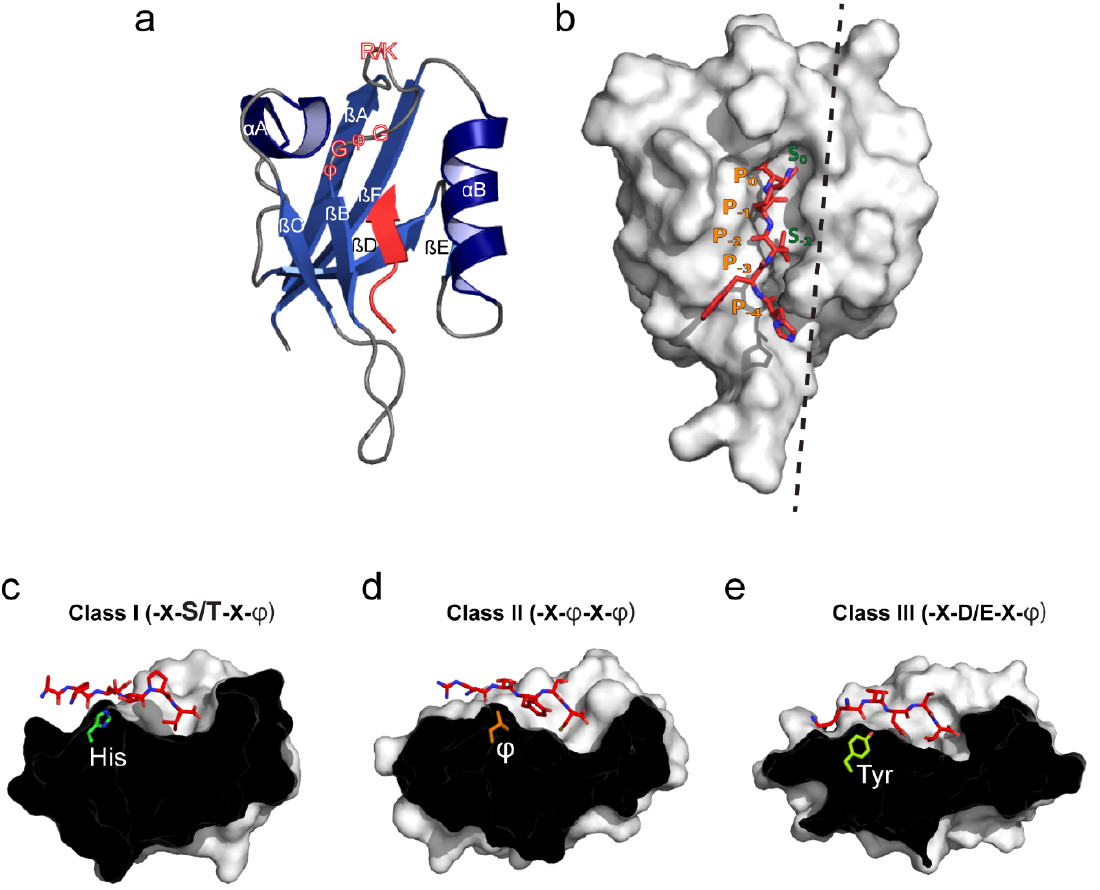
Figure 1. Structural overview of the canonical PDZ domain fold, ligand binding and peptide-based classification. ( a ) The canonical PDZ domain fold comprises two α -helices ( α A and α B) and six β -strands ( β A– β F) (PDB: 2LUI [22]). The ligand is shown in red and is stitched into the binding groove located between the α B helix and β B strand. The peptide/protein-binding groove is composed by the R/K-X-X-X-G- φ -G- φ (X—any residue; φ —hydrophobic residue) loop indicated in red outlined text; ( b ) Surface view of the canonical PDZ domain. Hydrophobic pockets S 0 and S -2 (for class II domains) are indicated in green. Correspondingly, the five C-terminal ligand residues are denoted from P 0 to P − 4 in orange. The black dashed line indicates the cross section plane used in panels c-e; ( c ) Class I binding domains usually recognize ligands with either Ser or Thr at P − 2 . The α B1 residue is usually His (PDB: 1TP3 [23]); ( d ) Class II binding domains recognize ligands with hydrophobic residues at P − 2 . The α B1 residue is often hydrophobic and allows for formation of a second hydrophobic binding pocket (denoted S -2 in panel b) (PDB: 1N7F [24]); ( e ) Ligands binding class III domains typically have Asp or Glu at P − 2 and Tyr at the α B1 position (PDB: 1B8Q